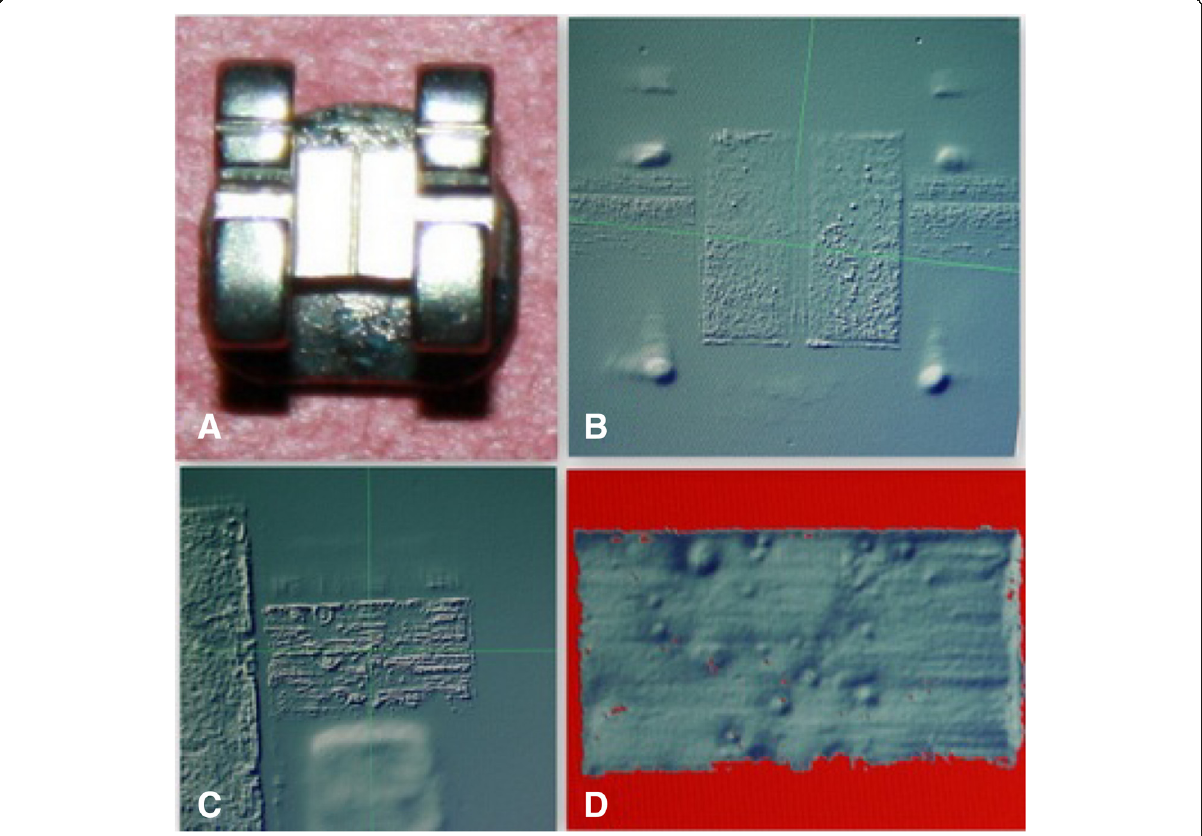
Fig. 4 a Stainless steel bracket, b bracket view under the three-dimensional profiler machine, c distal slot view of the bracket, and d distal slot view of the bracket after scanning showing the scanned slot